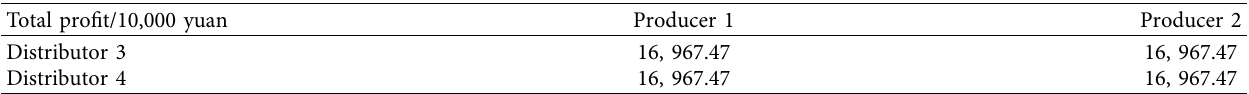
Table 3: Total profits of the producer-distributor subchain through coordinated optimization under the profit-sharing contract.